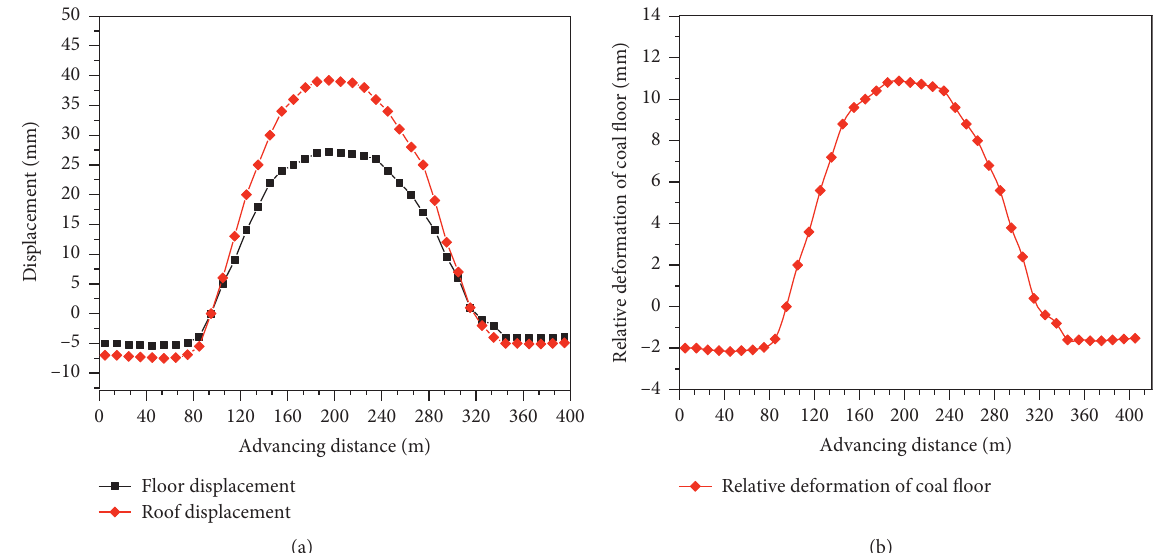
Figure 5: Displacement in the protected coal seam 7 1 at various stages of longwall retreat. (a) Vertical displacement at the roof and floor of protected coal seam 7 1 at various stages of longwall retreat. (b) Tensile displacement in the protected coal seam 7 1 at various stages of longwall